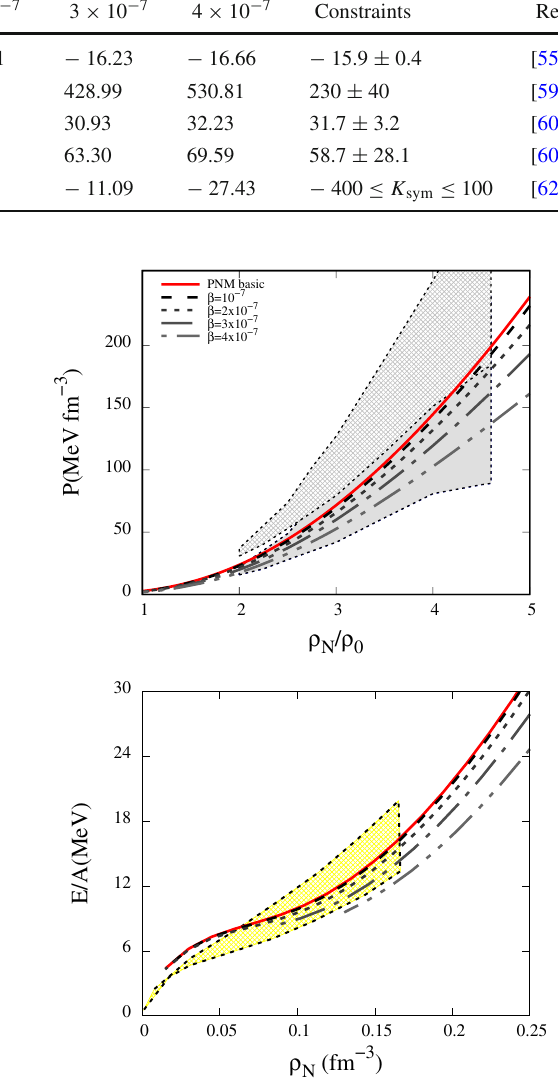
Fig. 1 (Top) our calculation results for EoS match the data from FOPI. But the results for the binding energy calculation are not trivial. (Bot- tom) binding energy as a function of nucleon density, the grey shaded area is experimental data from FOPI [54], the dashed box is the allowed binding energy at nuclear saturation density from Bethe–Weizacker mass formula. We also show the result from [55] as the red dot with the error bar. The minimum value of the binding energy are also shown with box-shaped dots to show whose value is still inside the dashed box [56]